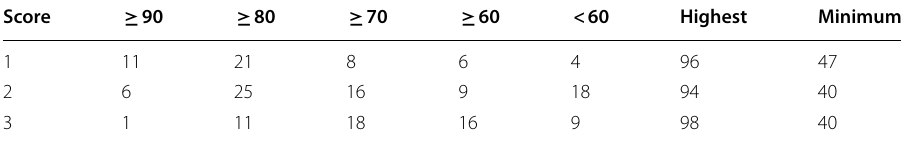
Table 3 Test results under different teaching